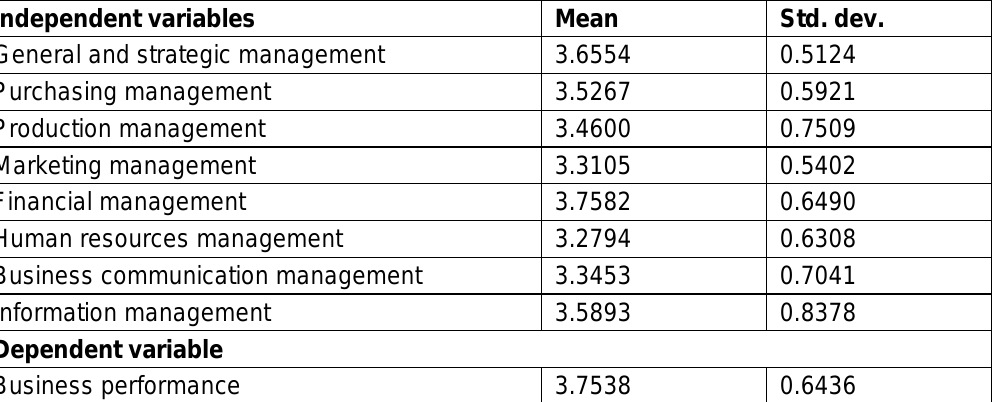
Table 2: Mean and standard deviation of the predetermined independent variables Independent